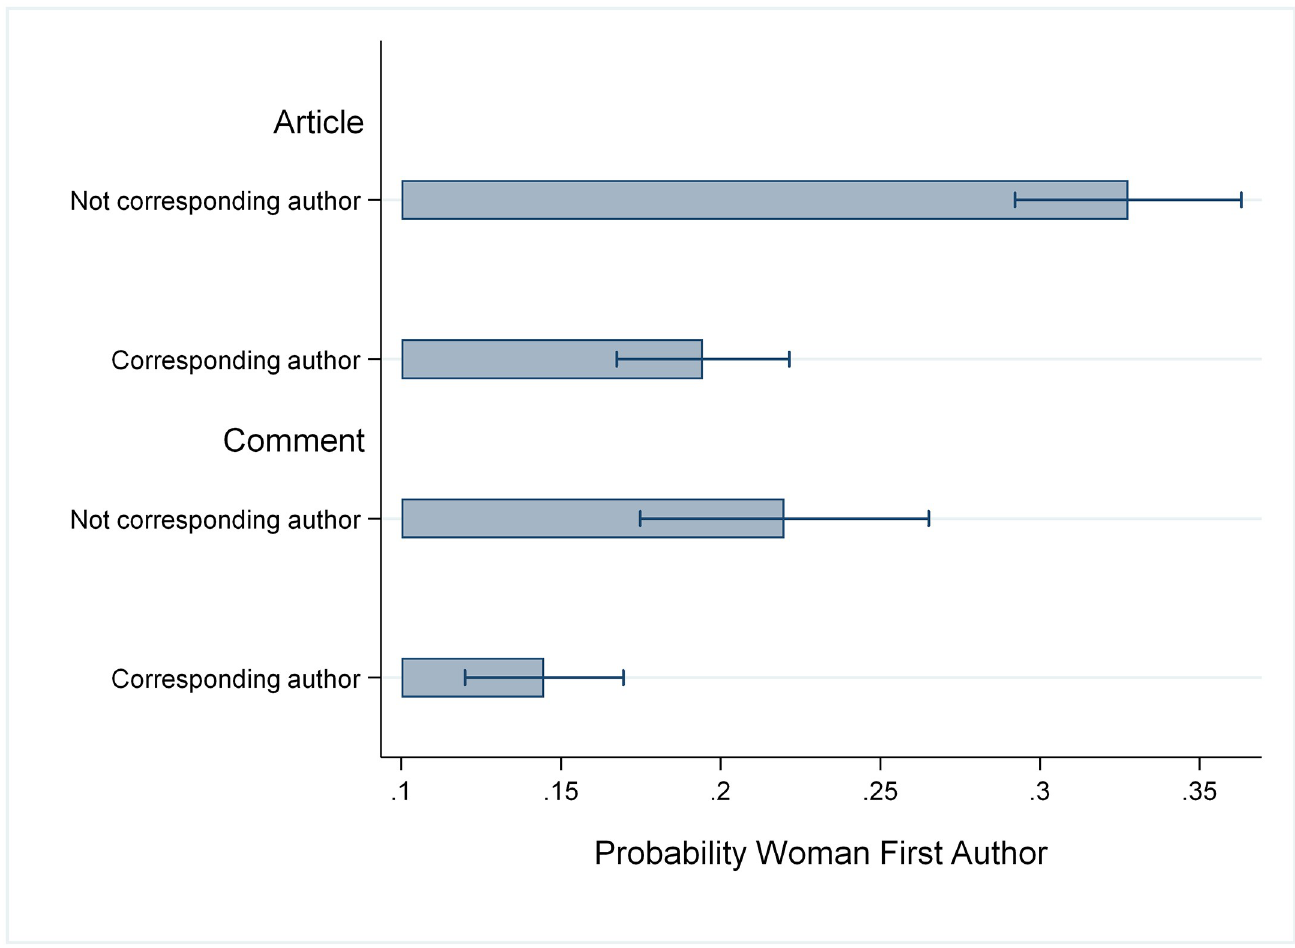
Fig 2. Estimated probability first author is a woman by publication-type and corresponding-author status.